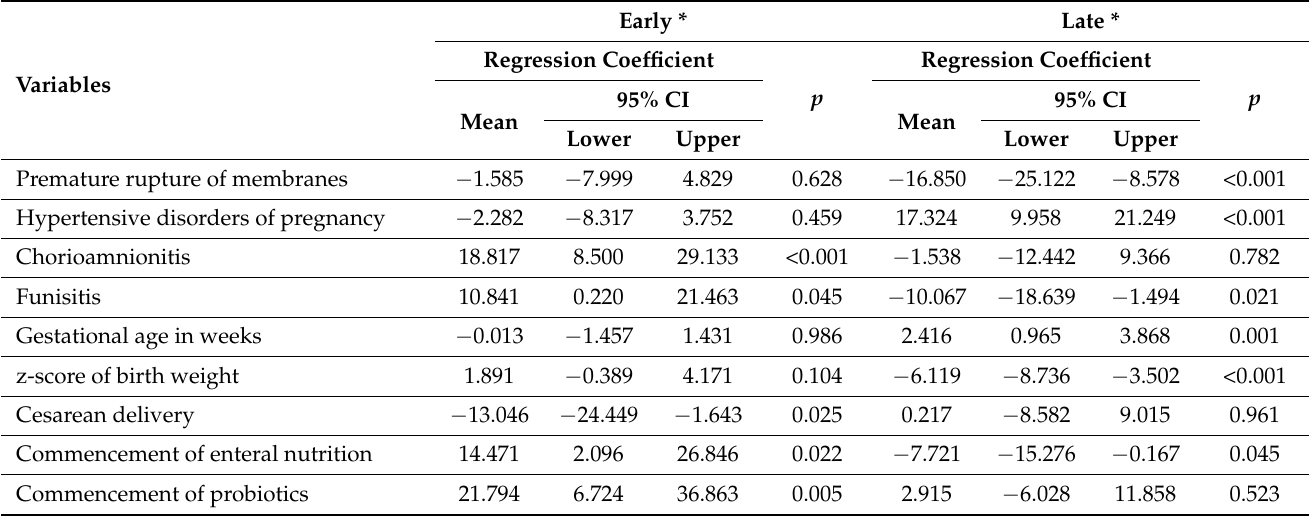
Table 4. Independent variables of alpha 1 acid glycoprotein levels during early and late